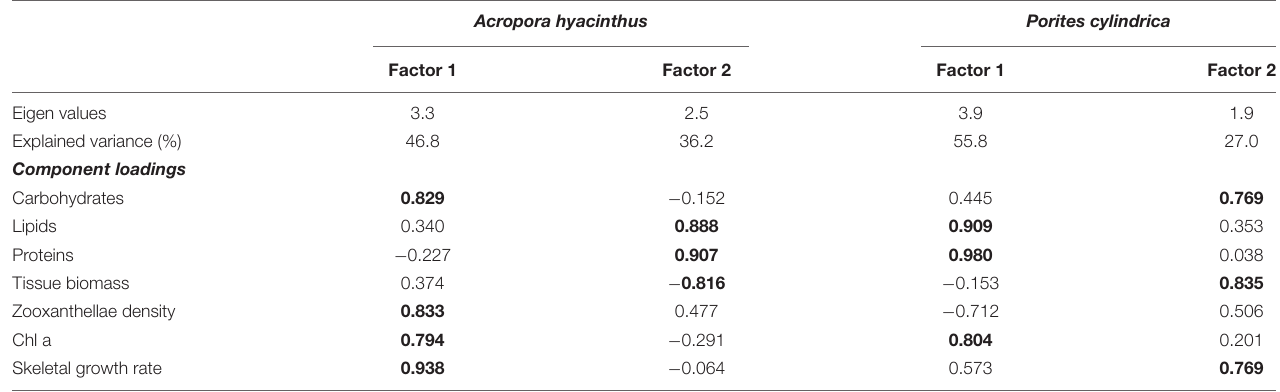
TABLE 2 | PCA of seven physiological parameters compiled from different treatments in two